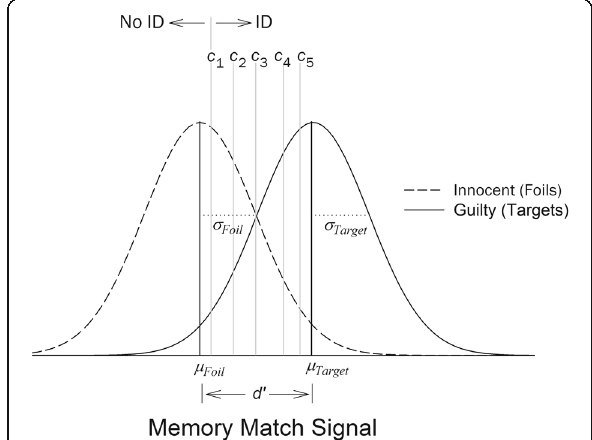
Fig. 2 Equal-variance Gaussian signal detection model for a showup or a lineup. For a showup, the model operates in the same way